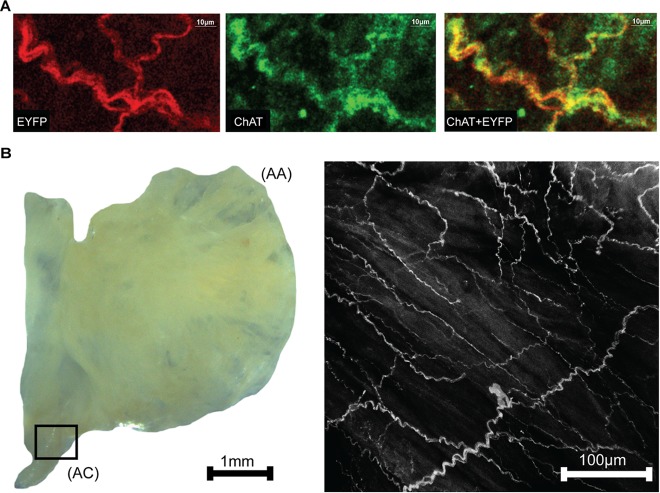
Images showing colocalization of ChAT with ChR2&EYFP within the nerve bundles of the right atrium. (A) The fluorescence of EYFP (left: 514 nm excitation) and Alexa Fluor (middle: 651 nm excitation) were imaged within the RA. Fluorescence overlap (right) confirmed selective expression of ChR2&EYFP within cholinergic neurons. (B) Bright field image (left) of a typical excised right atrium used for multiphoton fluorescence microscopy of neurons expressing ChR2&EYFP. AC, atriocaval junction; AA, atrial appendage. Extensive intertwining networks of nerve fibers expressing ChR2&EYFP are shown on the right for a region of the AC junction, denoted as the box shown in the bright field image.